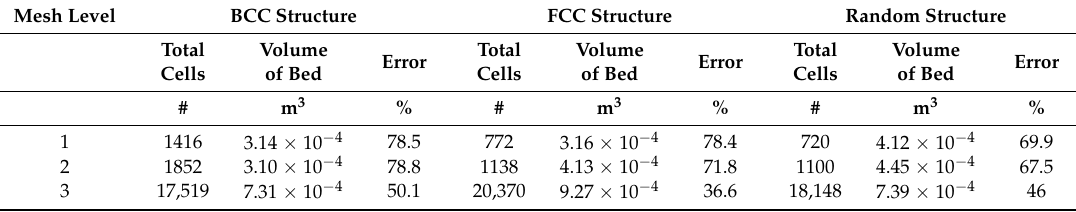
Table 2. Study mesh level accuracy by calculating the volume of bed in three